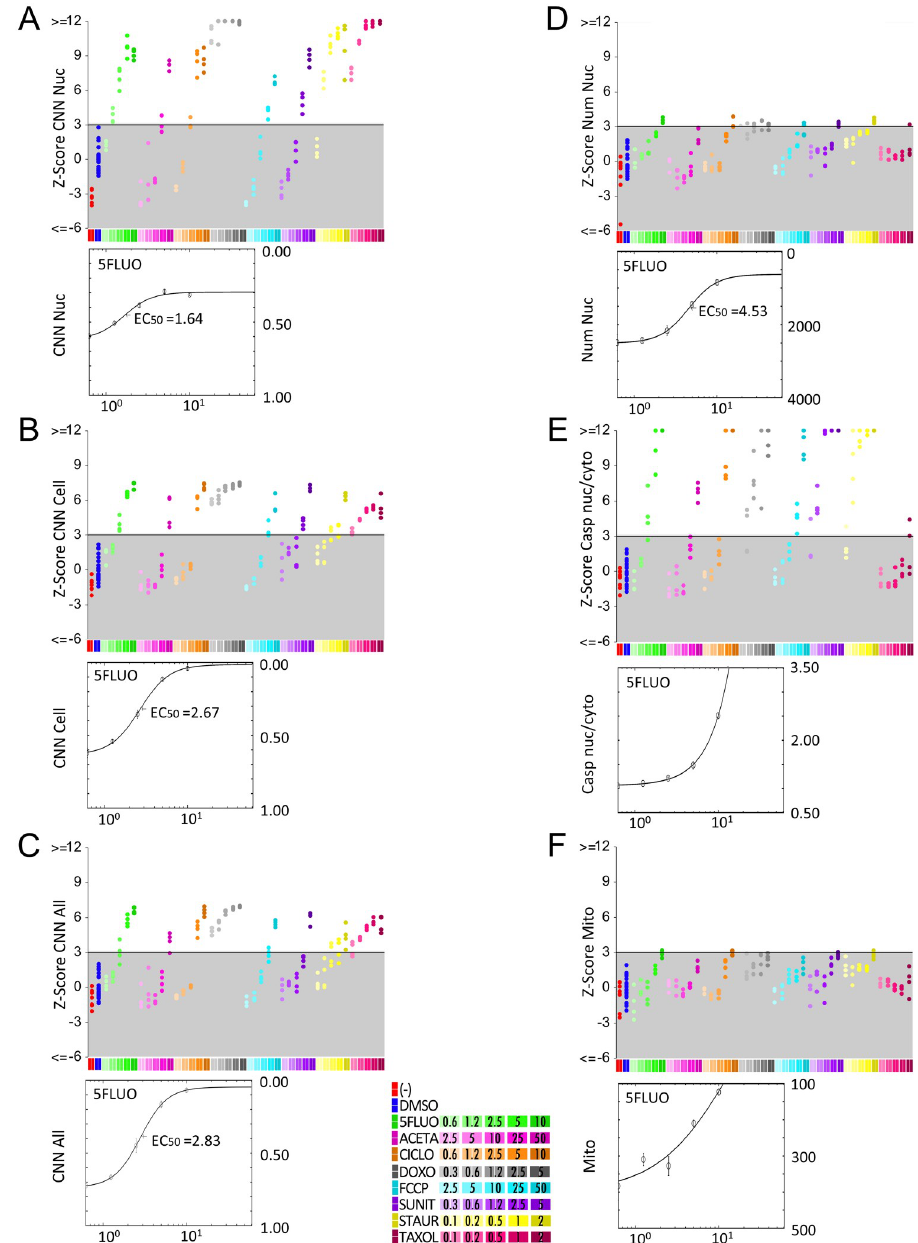
Fig 2. Sensitivity of CNN-based toxicity prediction compared with standard toxicity readouts. HL1 cells treated or not (-) with DMSO or the indicated concentrations of drugs ( μ M) from Experiment #1 were processed as described in the Materials and Methods. Plots display individual well toxicity readouts (top) and the 5-Fluorouracil dose-response curve fitted from well-averages, including the EC50 (bottom). Representative model results out of the 5 independent ones trained for each cropping strategy is shown. (A-C) CNN-based toxicity readouts: CNN Nuc (A), CNN Cell (B), and CNN All (C). (D-F) Standard toxicity readouts: Nuclei counting by standard image segmentation (Num Nuc) (D), mean Caspase 3/7 nucleus:cytoplasm ratio (Casp Nuc/Cyto) (E), and mean Mitotracker cytoplasmic intensity (Mito) (F). For each well, toxicity readouts were obtained by computing Z-scores (normalizing to DMSO-treated wells) with adjustment of the sign to display toxic effects as positive values. Z-scores > 3 represent toxic hits.